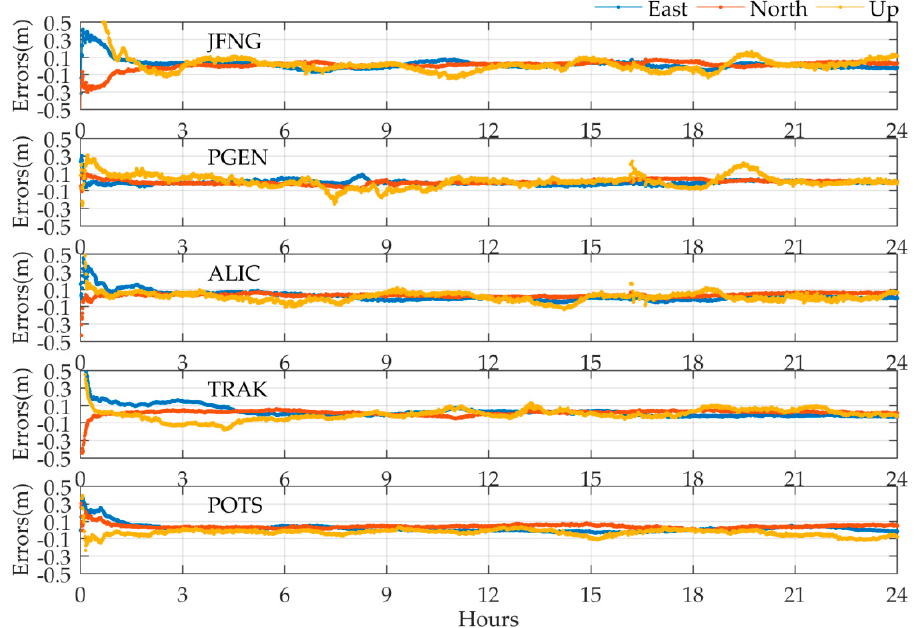
Figure 10. An example of time series of PPP positioning errors on 11 November 2018 for the five IGS stations using the MADOCA real-time product.